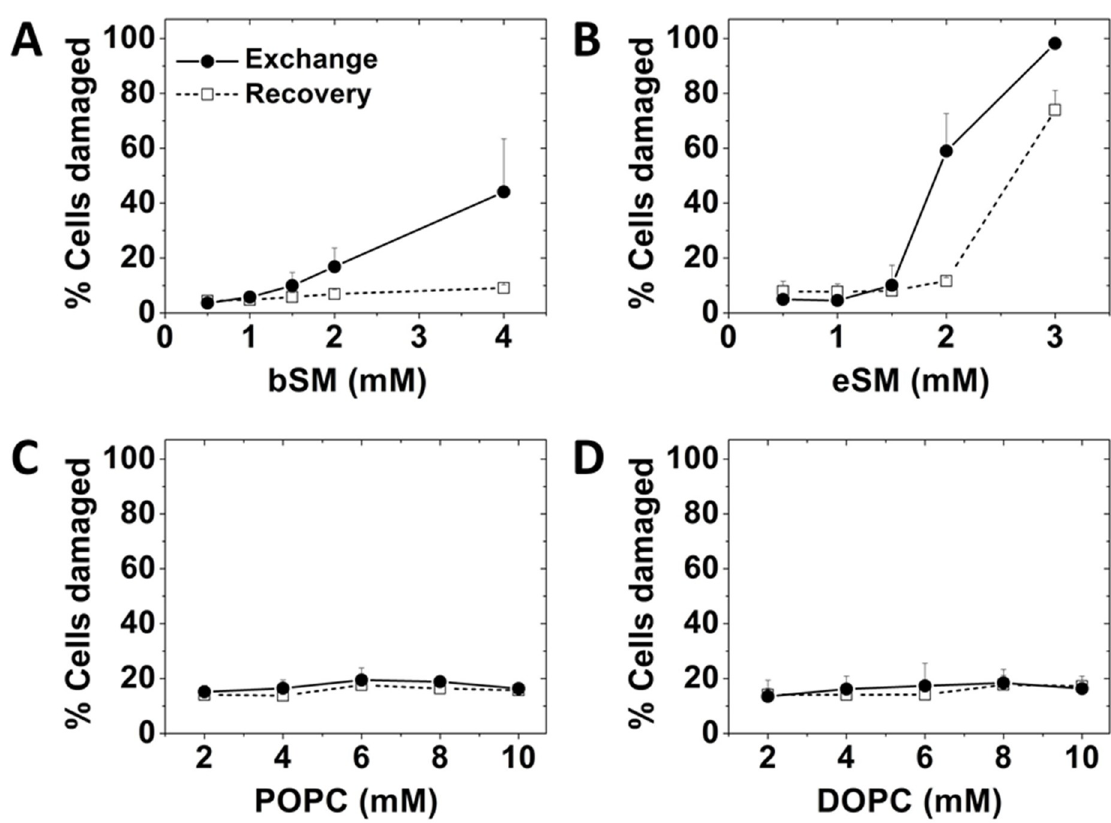
Fig 8. Percent damaged A549 cells after 1h lipid exchange at 26˚C with or without a 2h recovery step at 37˚C assayed with PI and Annexin V. Exchange was carried out using a range of concentrations of: A) bSM; B) eSM; C) POPC; D) DOPC. Exchange was carried out in 6 cm diameter plates at 26˚C with 1.5 ml of lipid plus 40mM M α CD. Recovery was carried out at 37˚C in the same plates with 2 ml of complete growth medium. In untreated samples there was about 5% damaged cells. Mean and standard deviation from three experiments is